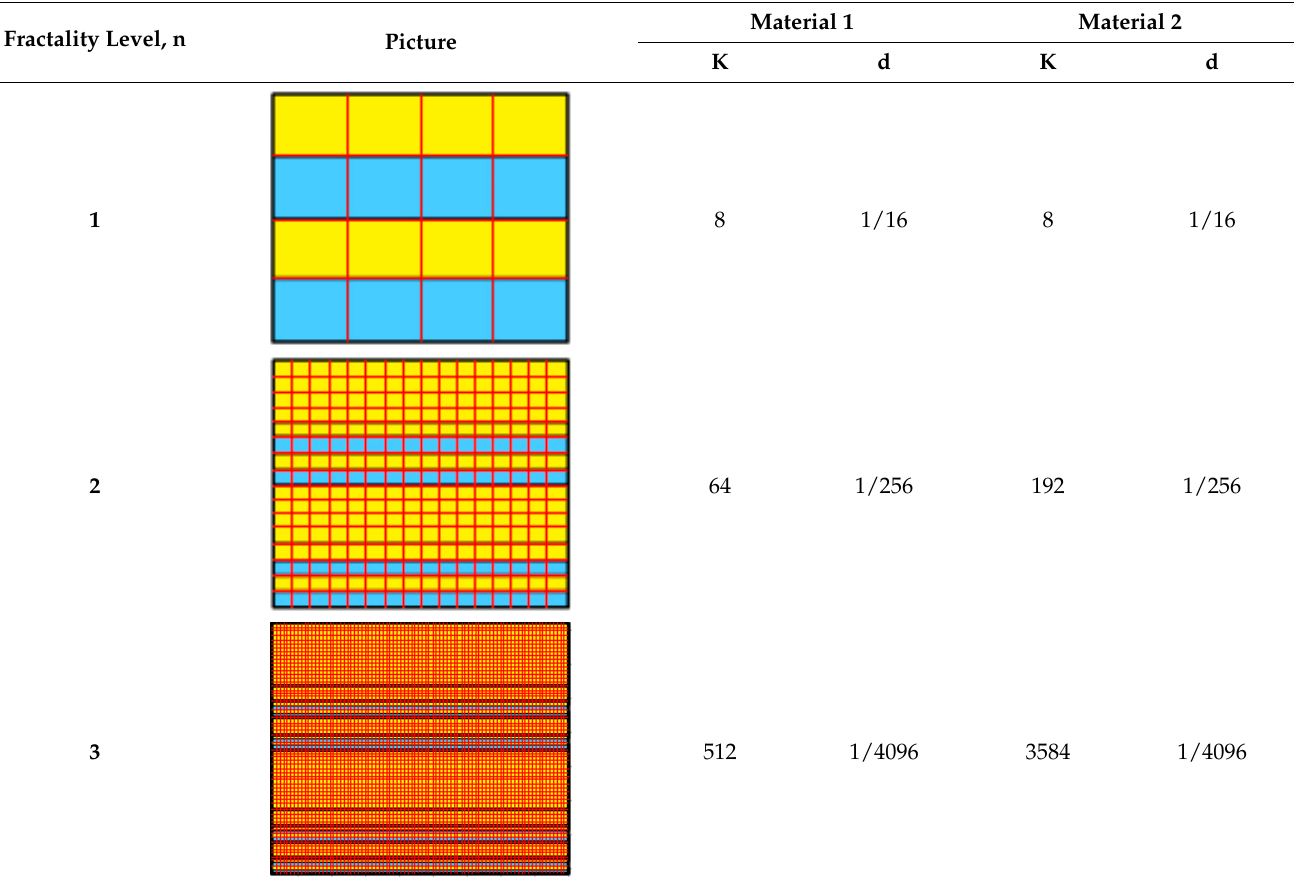
Table 4. Evolution of the hierarchically constructed composite model.